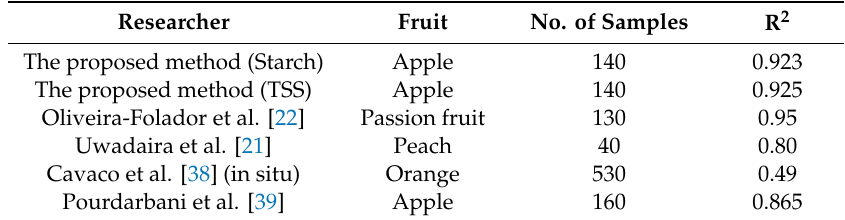
Table 5. Comparing the performance of the proposed methods on non-destructive estimation of starch content and TSS with other methods. Researcher Fruit No. of